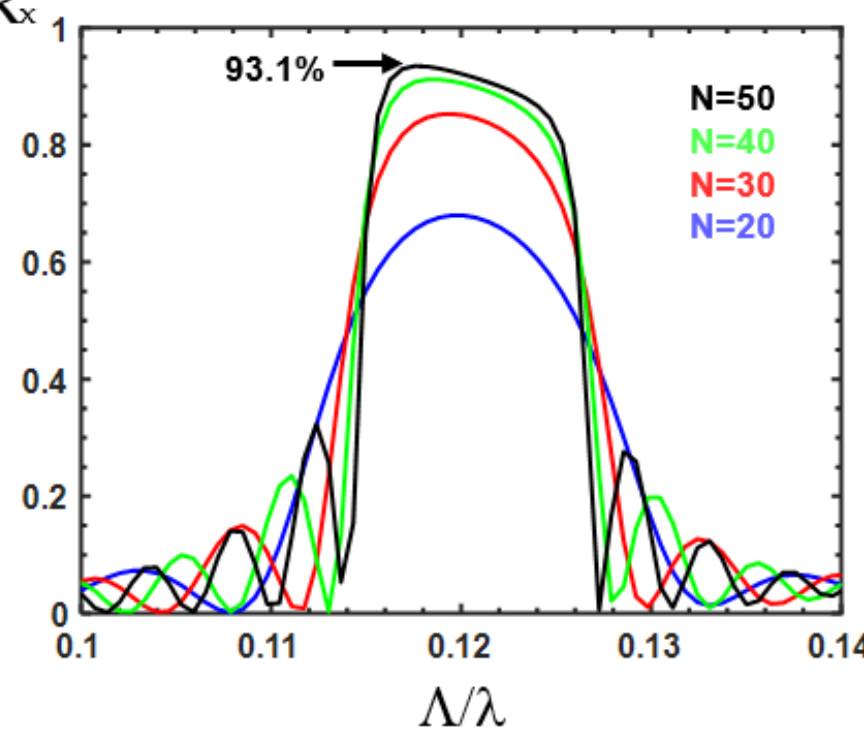
Figure 7. Reflection spectra of the E X -polarized light in the reflective polarization rotator in the silicon waveguide for different numbers of periods.